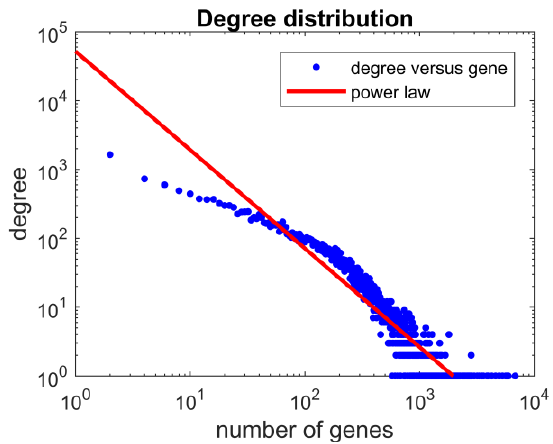
Figure 3. Degree distribution of the LCC. The horizontal coordinate represents the number of genes, the vertical coordinate represents the frequency of the degrees, and the horizontal and vertical coordinates are expressed as double logarithmic coordinates.